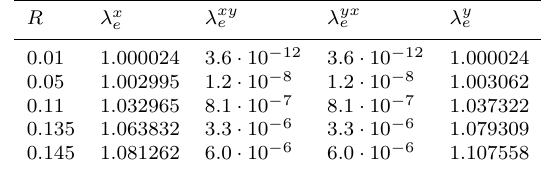
Table 6. The components of the effective conductivity tensor Λ e for the configuration of the inclusions given in (4.1) for the material constants λ k = 100, γ k = 100, β k = − 100, M = 9. R λ x e λ xy